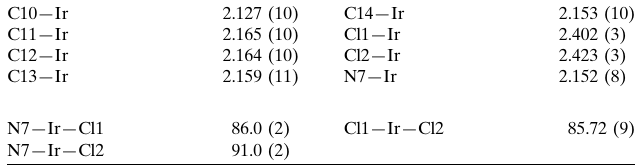
Selected geometric parameters (A˚ , (cid:2) ).